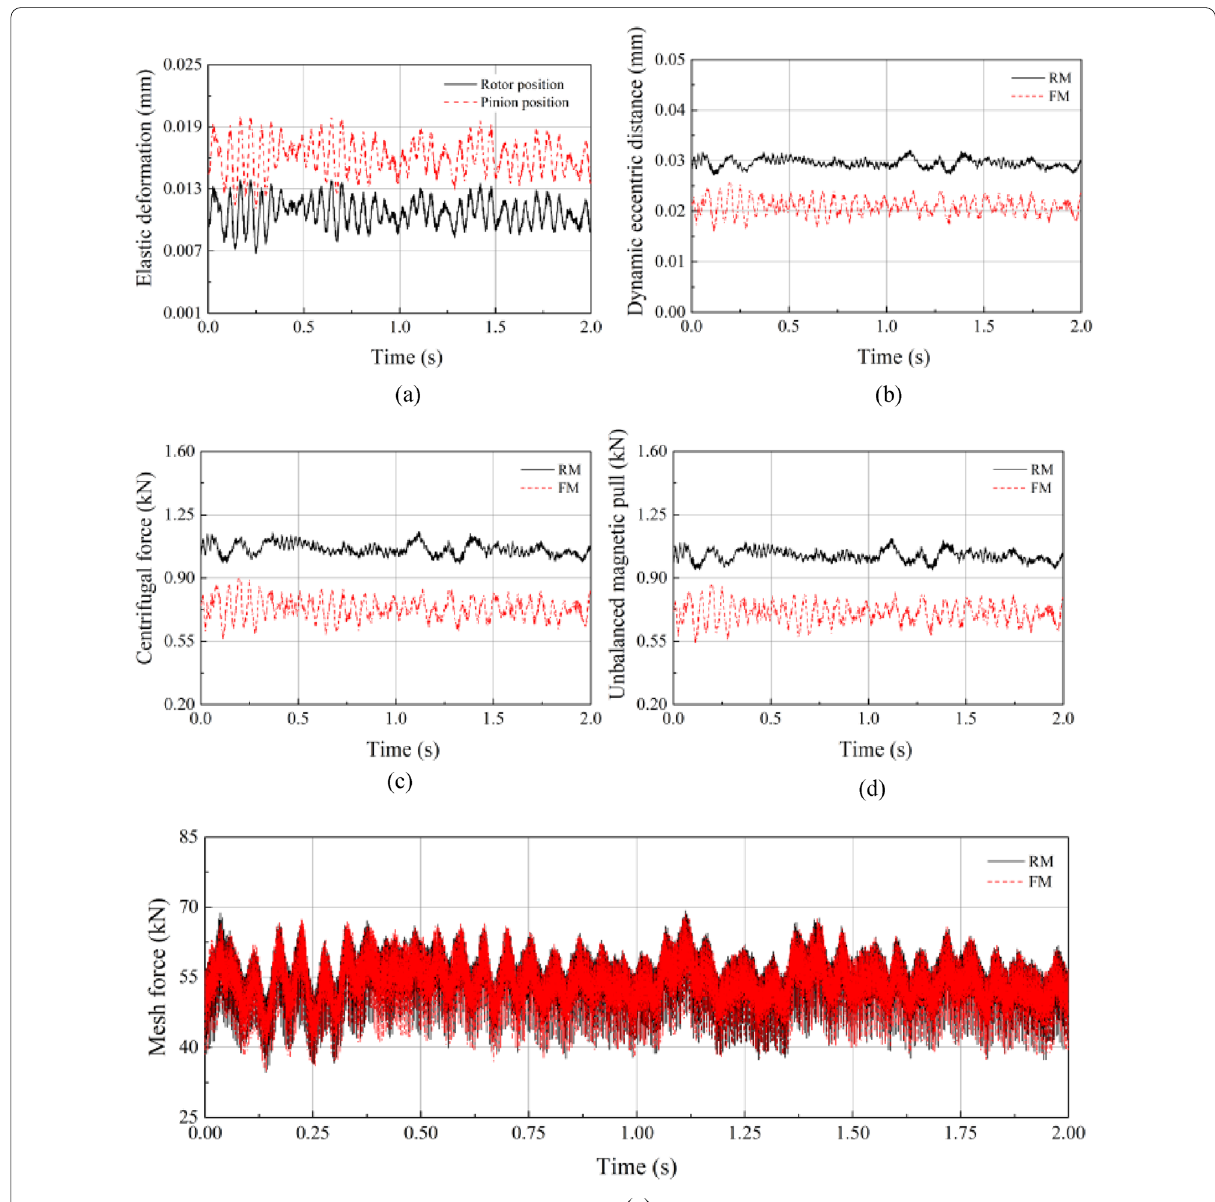
Figure 7 Effect of elasticity of shaft and support bearings on the internal dynamic forces of traction motor: a elastic deformations of the shaft, b dynamic eccentric distance of rotor, c centrifugal force of rotor, d UMP, and e mesh